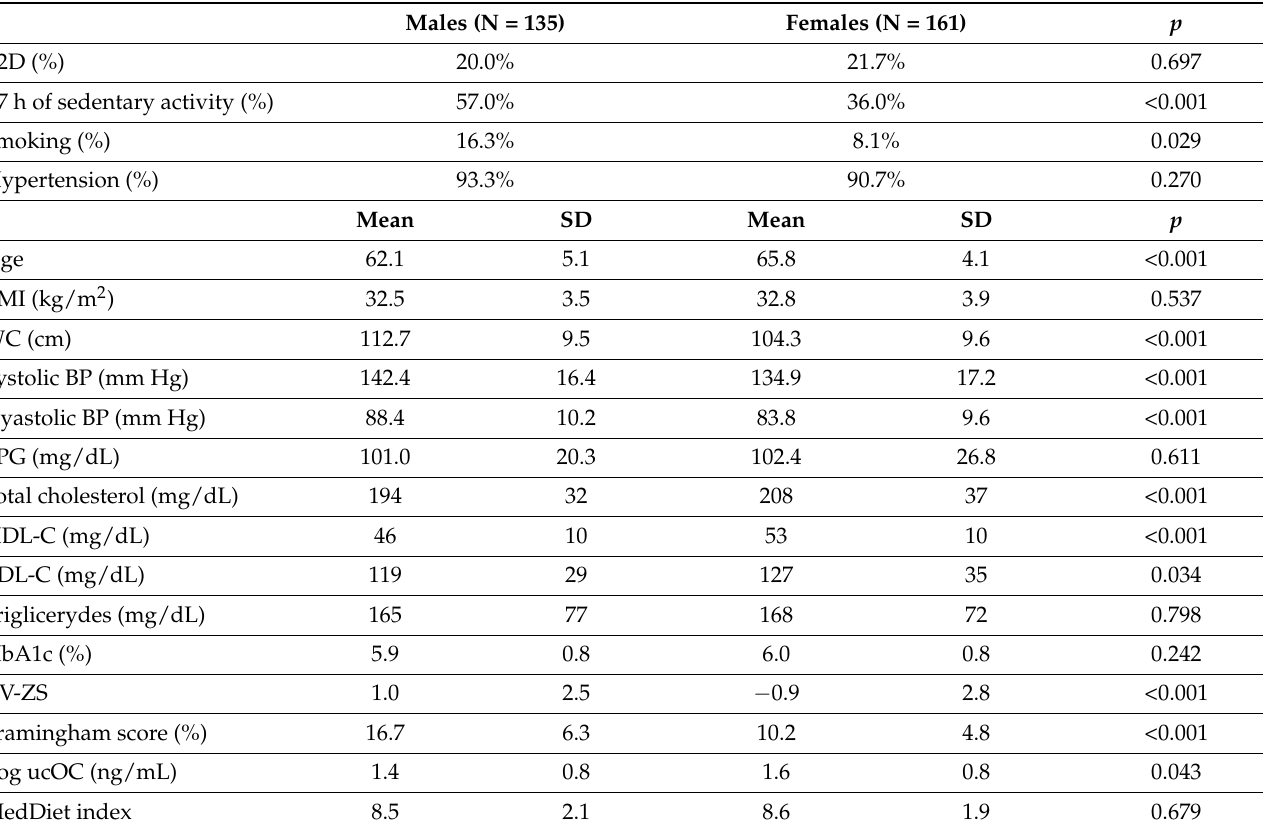
Table 1. Baseline characteristics of the study population by